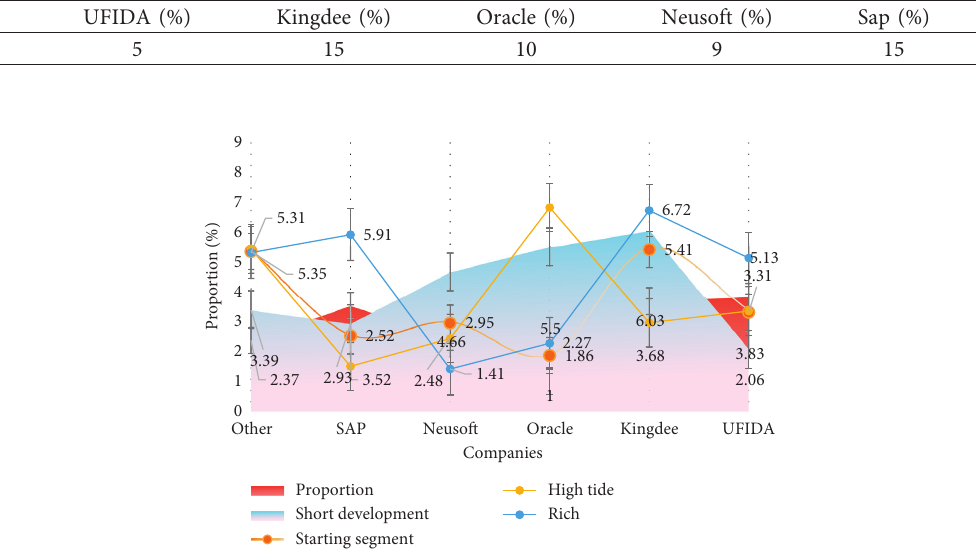
Figure 7: Market utilization rate of e-HR system. Table 9: Market utilization rate of e-HR system data.